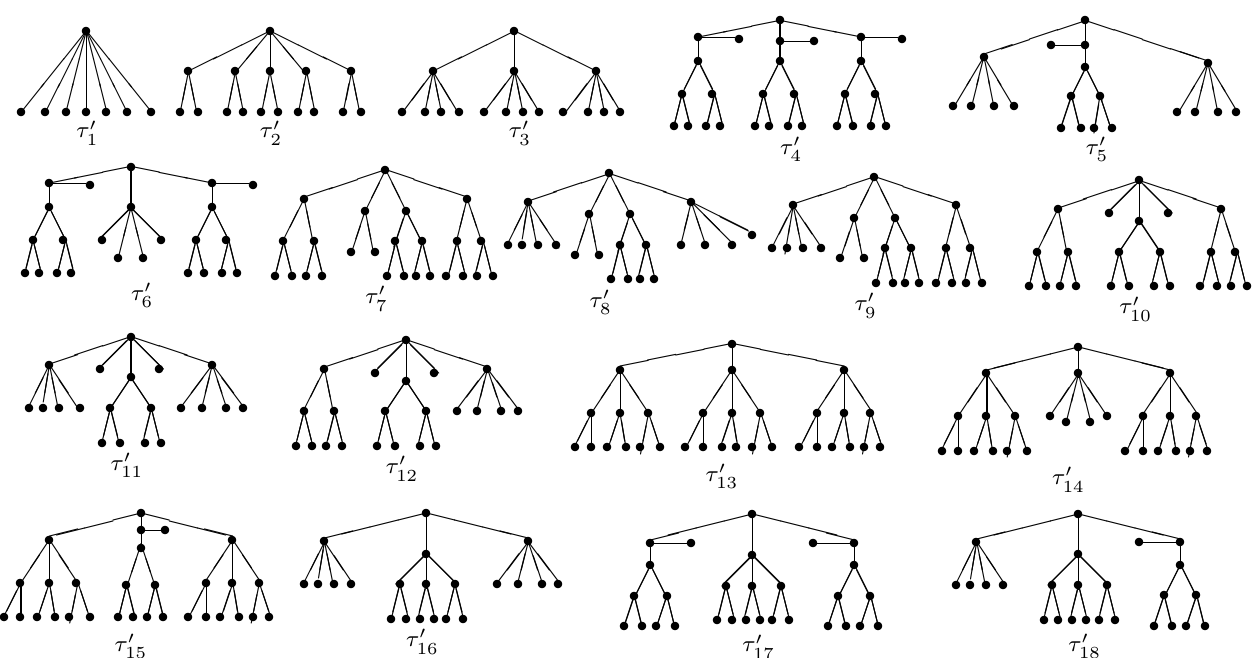
Fig.2. 4-cutwidth critical tree set